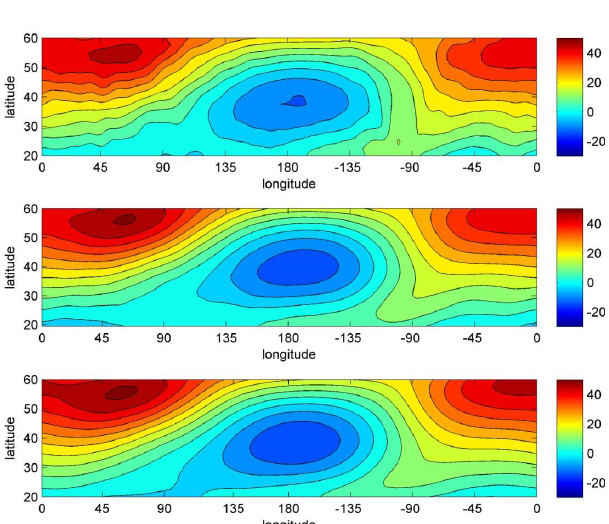
of the stratosphere (10 hPa) and predominately in the two core sectors (not shown in the